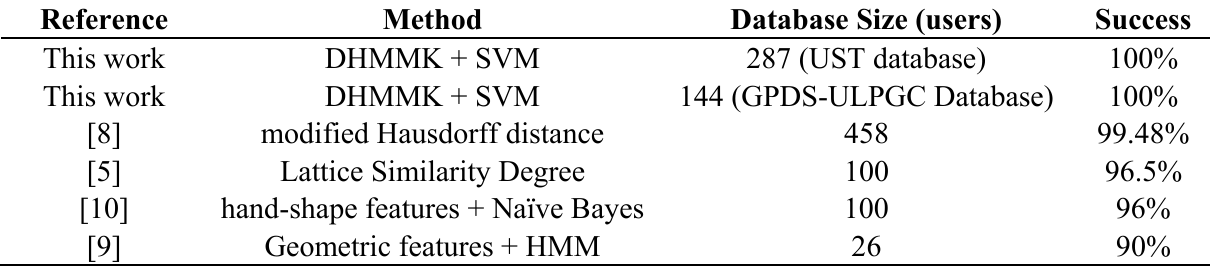
Table 8. Comparison with the state-of-the-art, for references which use hand-shape features.